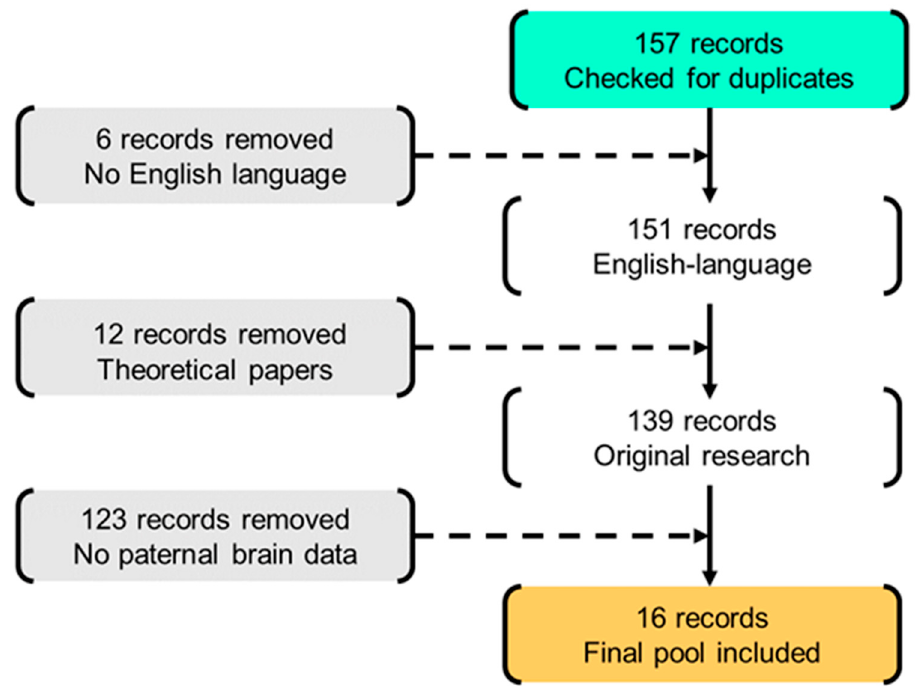
Figure 1. Flow chart of study selection.